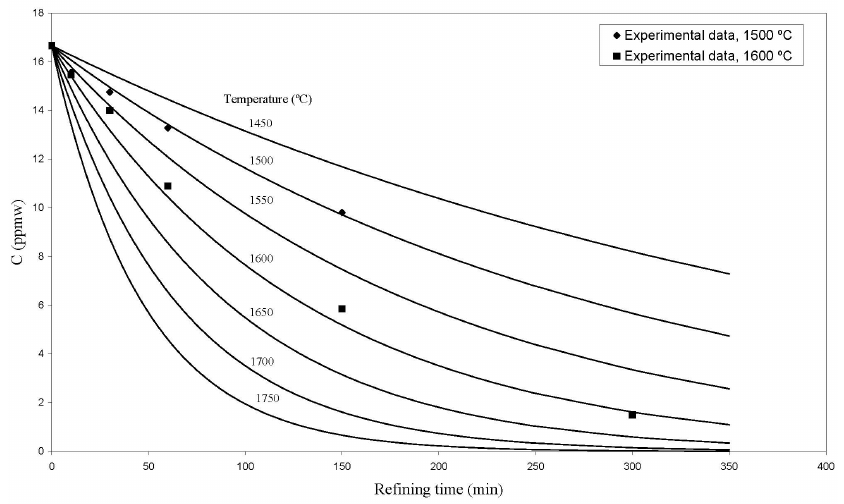
Figure 3. The changes of phosphorus concentration with refining time for different temperatures.